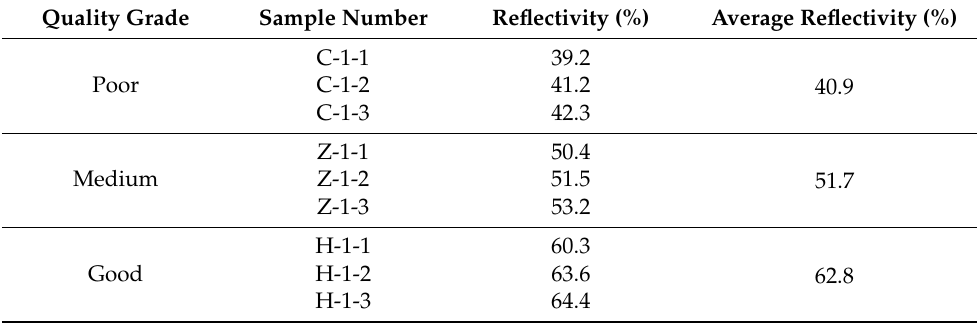
Table 1. Surface reflectivity of pearl samples with different quality grades.